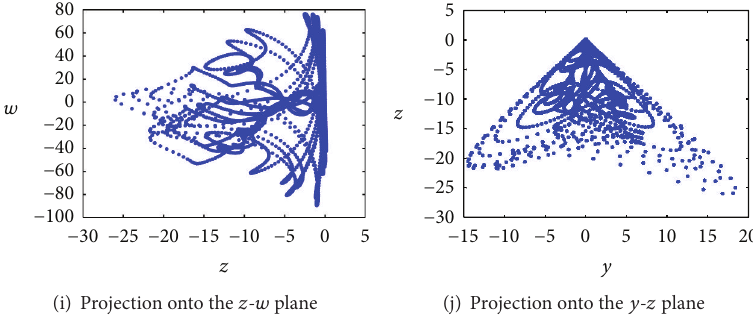
Figure 2: Phase portraits of the dynamic system when 𝑥 = 11.28 , 𝑦 = −11.21 , 𝑧 = −9 , and 𝑤 = 20.49 and 𝑎 = 0.9 , 𝑏 = 12 , 𝑐 = 2 , 𝑑 = 0.06 , and 𝑒 = 20 .